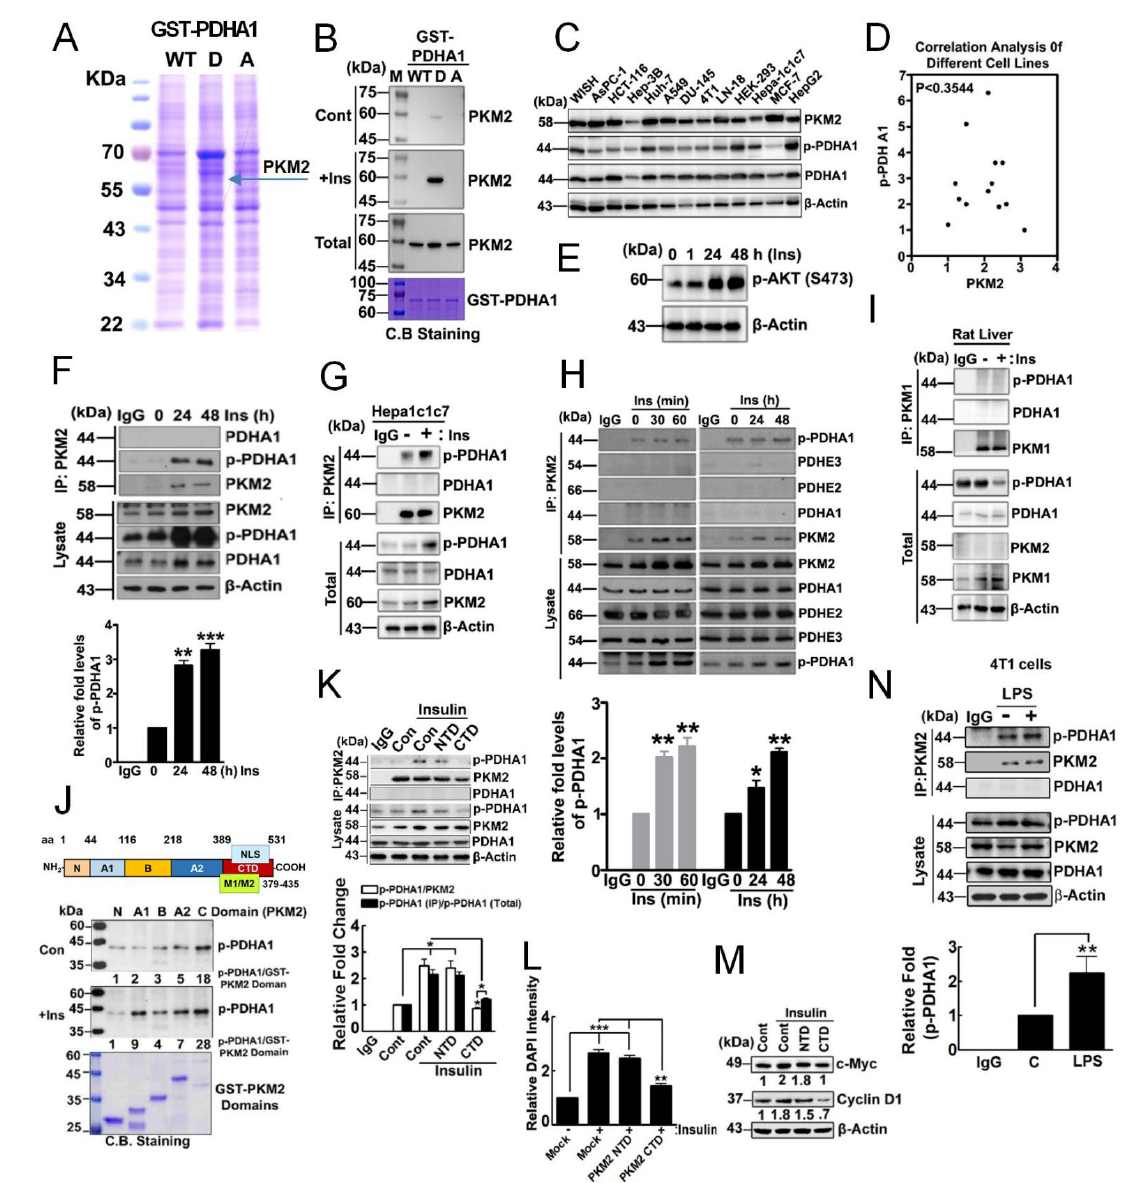
Figure 1. p − Ser293 PDHA1 binds to PKM2. ( A ) PC12 cells were stimulated with NGF100 ng/mL, lysate was then incubated with purified GST-PDHA1 WT, S293D, and S293A mutant beads, proteins were separated by SDS-PAGE, and target protein species identified through MALDI-TOF analysis. ( B ) Purified recombinant protein beads were incubated with HepG2 cell lysates treated with insulin 100 nM for 48 h, and bound PKM2 was identified by immunoblotting. ( C ) Relative PKM2, PDHA1, and p-PDHA1 levels in several cancer cell lines were determined by immunoblotting. ( D ) Correla- tion between p-PDHA1 and PKM2 levels in several cancer cell lines is presented. ( E ) p-Ser473 AKT levels in HepG2 cells were detected by Western blotting in the presence of insulin (100 nM) in indi- cated time. ( F – H ) HepG2 and Hepa1c1c7 cells were stimulated with insulin (100 nM in indicated time). Co-immunoprecipitation with PKM2 and then indicated proteins were detected. ( I ) Insulin (10 U/kg body weight for 2 h) treated in rat liver was prepared and immunoprecipitated with PKM1,